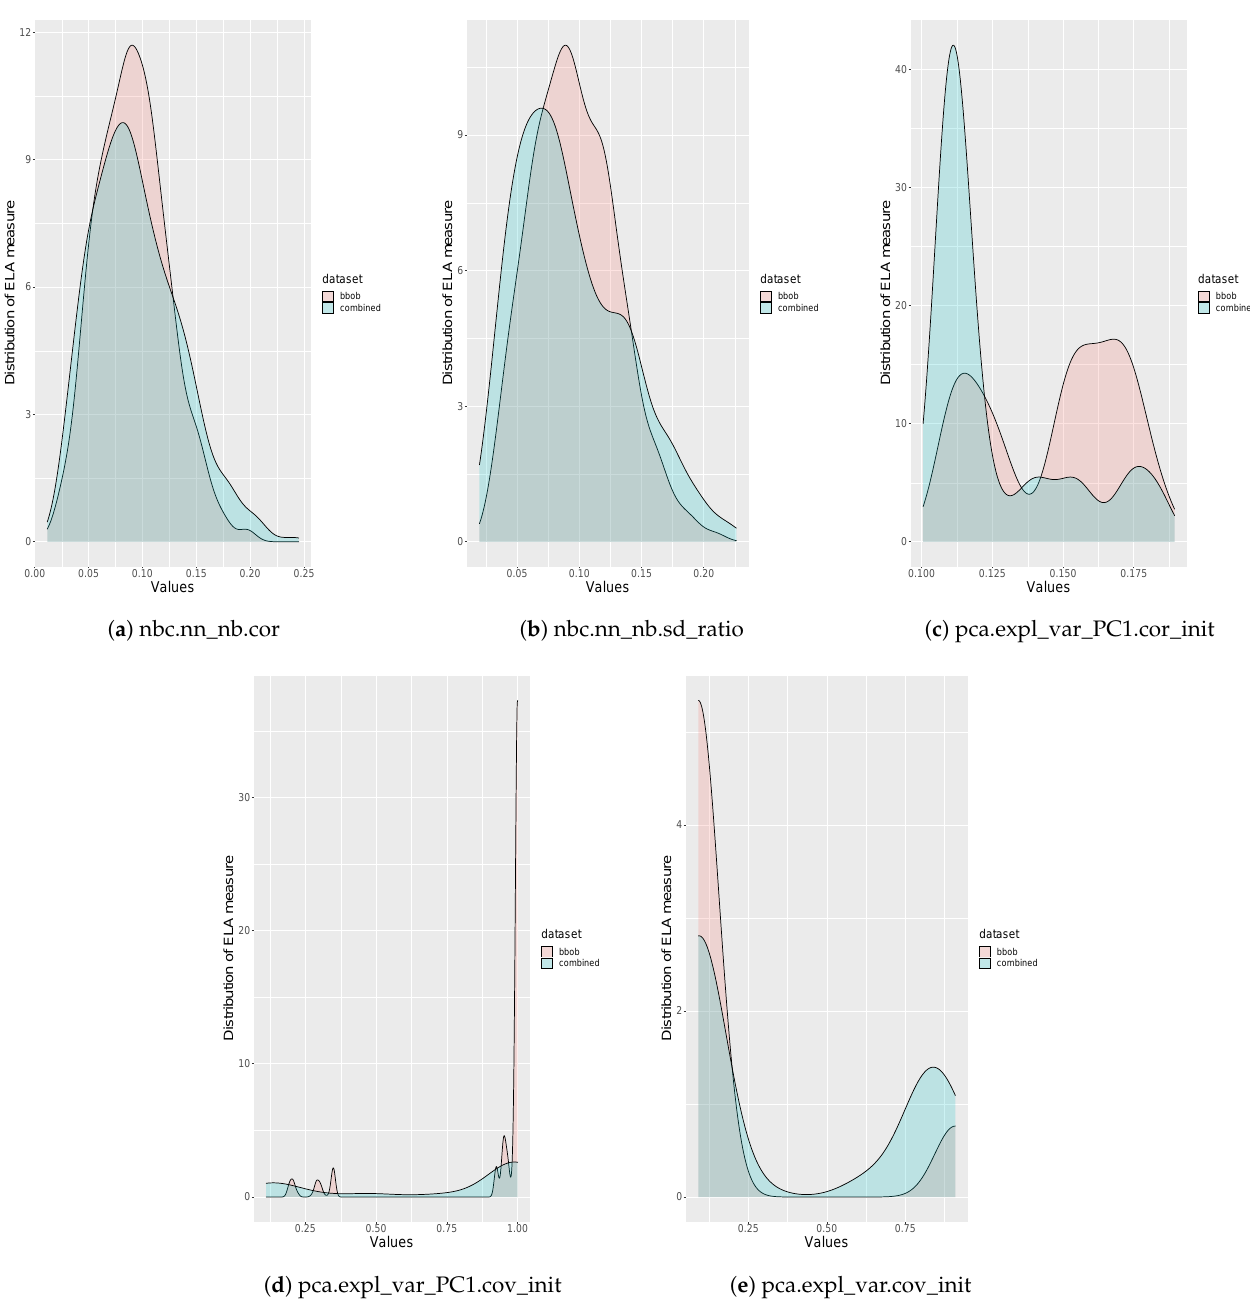
Figure 10. Comparison of the distributions of the BBOB benchmark suite and the proposed benchmark suite for all of the ELA measures used as input to the SOM